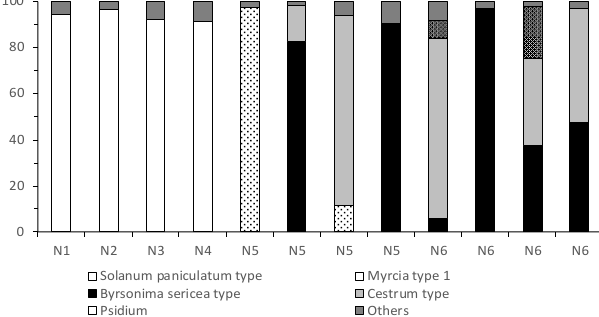
Fig 2. Proportion (%) of different pollen types in brood cells from six nests (N1 to N6) of Centris ( Centris ) flavifrons . Each column represents one cell, and the sequence of cells is the same presented in